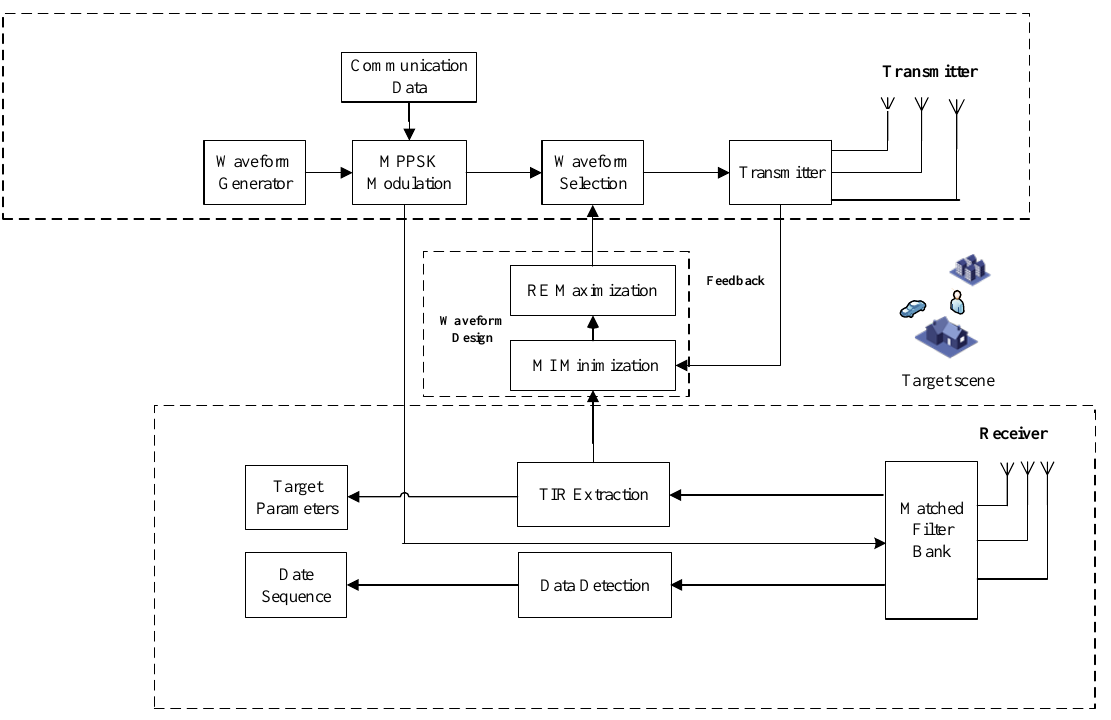
Figure 1. The system architecture of adaptive MIMO radar-communication transceiver.